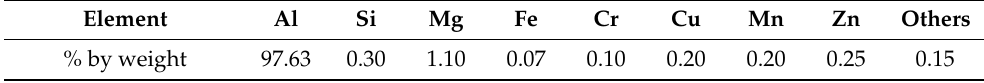
Table 2. Chemical composition of